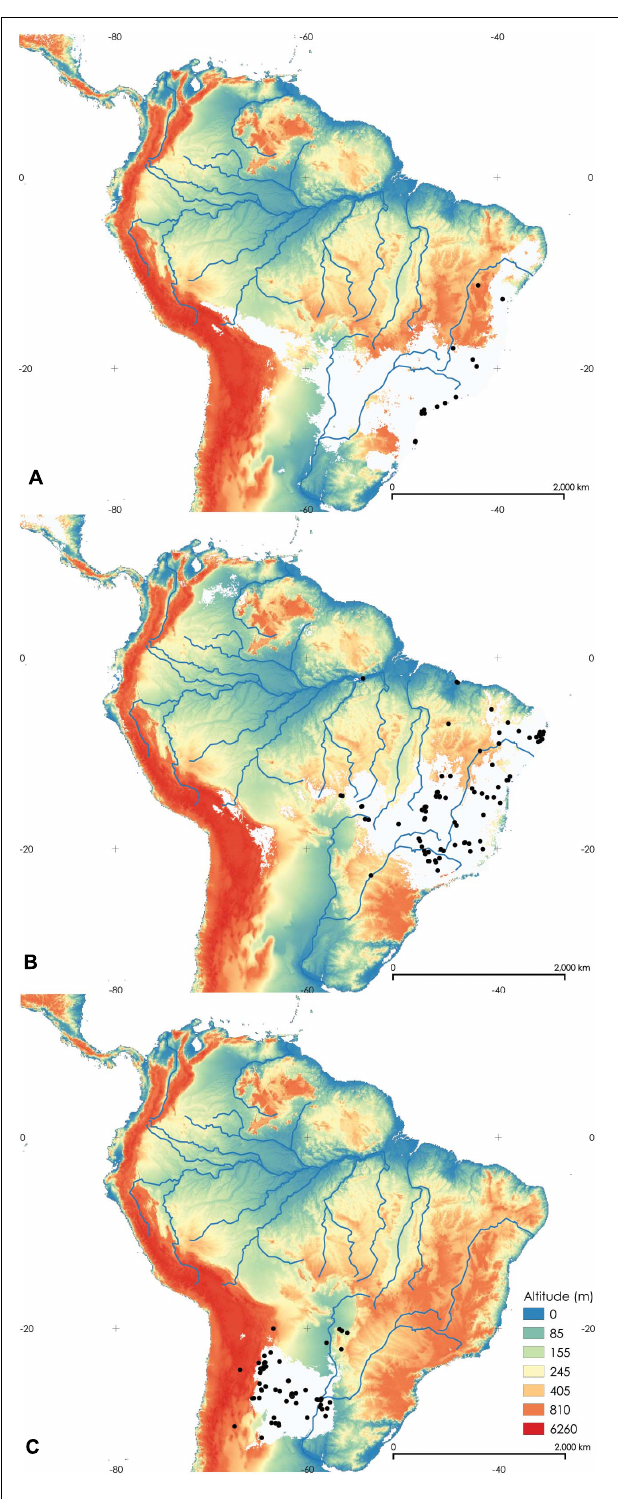
FIGURE 5 | Maps of the potential distribution of Rhodniini based on 19 bioclimatic variables in the study area. (A) Rhodnius domesticus , (B) Psammolestes tertius , and (C) P. coreodes . The white areas comprise the probability values at which 90% of the presence points fall within the potential area. The black dots indicate records of each